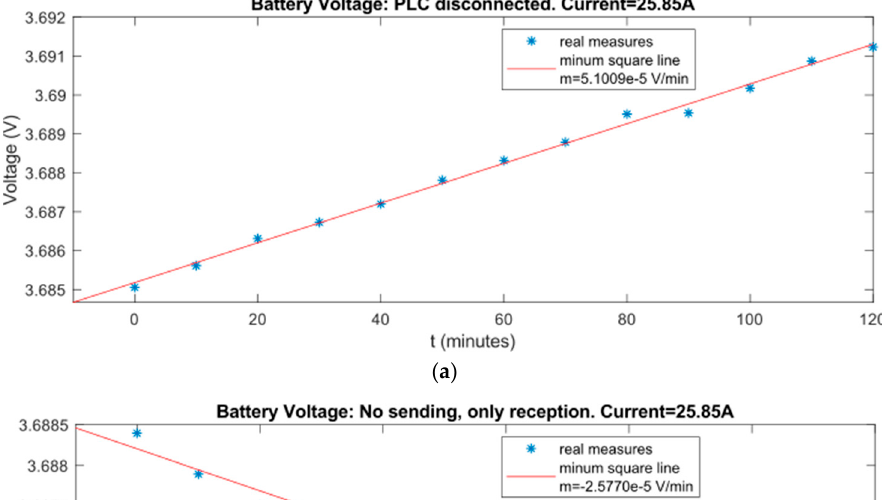
( b ) Figure 20 . ( a ) Amplitude error; and ( b ) phase error. The results of this experiment indicate that the synchronization between nodes is strong enough to let us compare two signals (amplitude and phase measures) and locate faults in lines using the proposed location algorithm. 8.3. Energy Harvesting The energy harvesting subsystem must provide enough power to keep the nodes alive during a normal function of the lines. Moreover, it needs a battery to operate during a certain amount of time after a fault. The sensor node contains a Li-ion battery that has a capacity of 2600 mAh. As described below, the system has been designed to be able to charge the battery during its normal functioning period when the current through lines is 25 A (but it can be designed using a bigger core to charge the battery even with lower current). Taking this into account, we can calculate